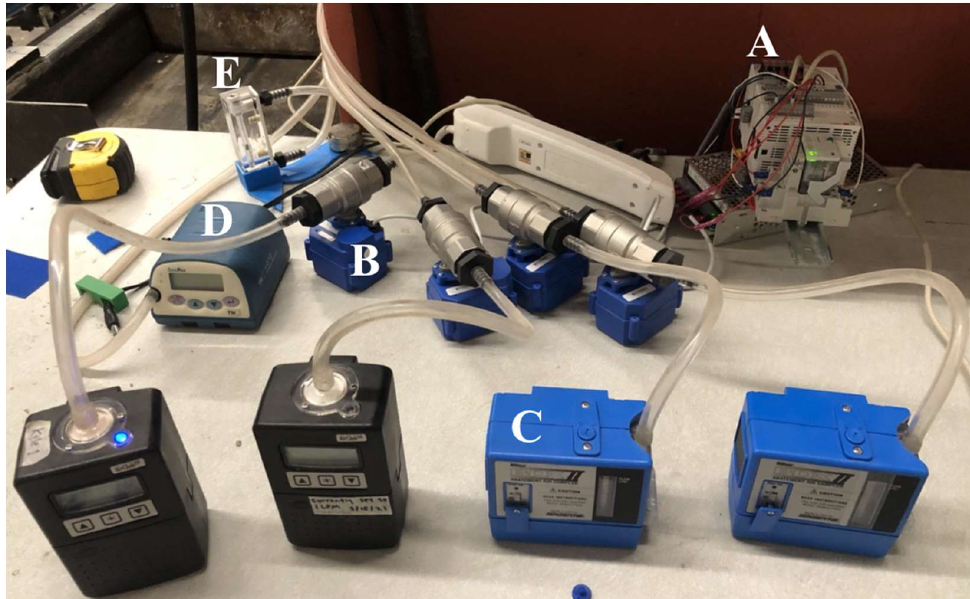
Figure 3. ( A ) Data acquisition interface and power unit that controls when dust is collected and flushed out of the system; ( B ) Electric ball valves to control the on and off of air flow through the cyclones and TDS; ( C ) Pumps running at 1.7 or 1.0 L per minute; ( D ) Real-time dust concentration monitor, ( E ) Rotameter currently placed in-line before testing to ensure pumps are running at appropriate flow rate.